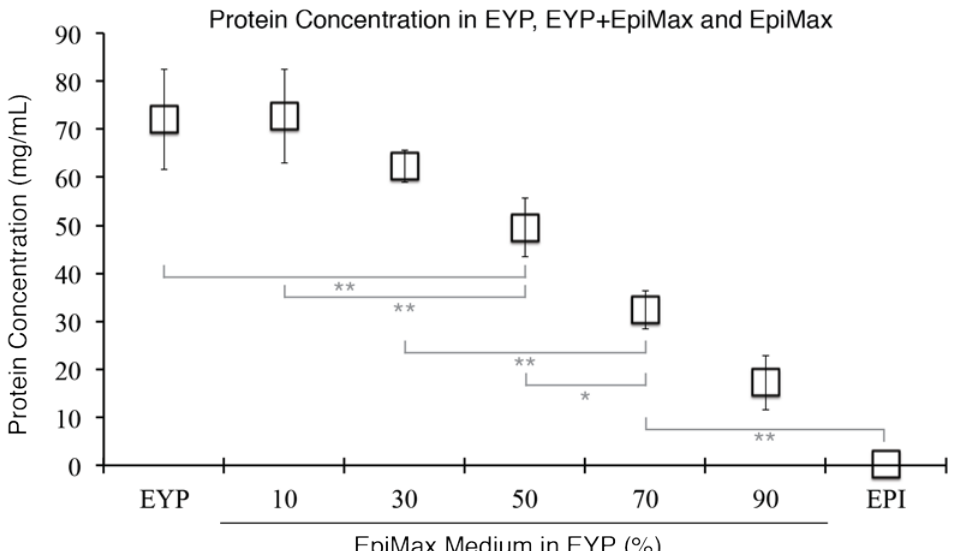
Figure A1. Graphical Representation of EYP’s Mean Protein Concentration as a Function of EpiMax Medium Concentration. Protein quantifications of EYP, EYP + Medium or Medium were performed with Bicinchoninic Acid assay. Error Bars = Standard Error. For statistical analysis (grey lines) we used one-way ANOVA followed by Tukey’s Post-Hoc test with p -values = * < 0.05, ** < 0.01.